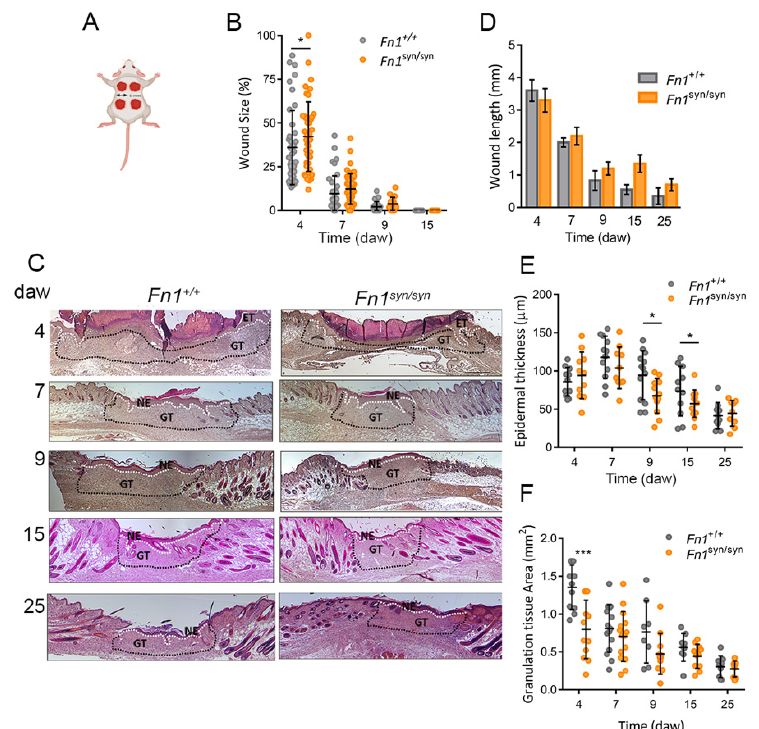
Figure 1. Analysis of in-vivo cutaneous wound healing in mice expressing fibronectin with the synergy site inactivated. ( A ) Schematic representation of the wound healing protocol. ( B ) Analysis of wound size calculated as the wound area at each time point referred to its area at day 0. n = the number of wounds analysed in Fn1 +/+ , Fn1 syn/syn respectively, at the mentioned time point. n = 57, 62 (0 days after wounding; daw); n = 40, 41 (4 daw); n = 38, 47 (7 daw); n = 21, 18 (9 daw); n = 12, 12 (15 daw). ( C ) Representative H&E images from epidermal wounds at the different time points in Fn1 +/+ and Fn1 syn/syn mice. The granulation tissue is indicated with dotted lines. ( D ) Quantification of the cross-sectional wound length measured in H&E images as the distance between wound edges at the different time points. ( E ) Quantification of the mean epidermal thickness in Fn1 +/+ and Fn1 syn/syn wounds. ( F ) Quantification of the granulation tissue size in Fn1 +/+ and Fn1 syn/syn wounds. Values are shown as mean ± SEM. Distribution of the samples was assessed by Shapiro–Wilk´s test. Statistical analysis was performed using Student t -test, and Mann–Whitney U test was used in B. p -value * p < 0.05 and *** p < 0.001. ET epidermal tongue; NE new epidermis; GT granulation tissue. Scale bar in ( C ), 200 µm.